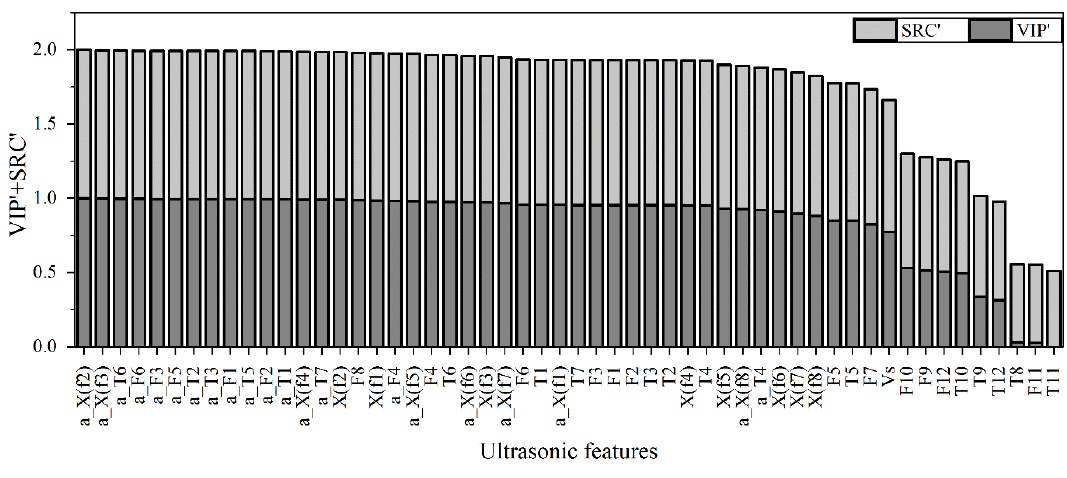
Figure 5. The importance of each